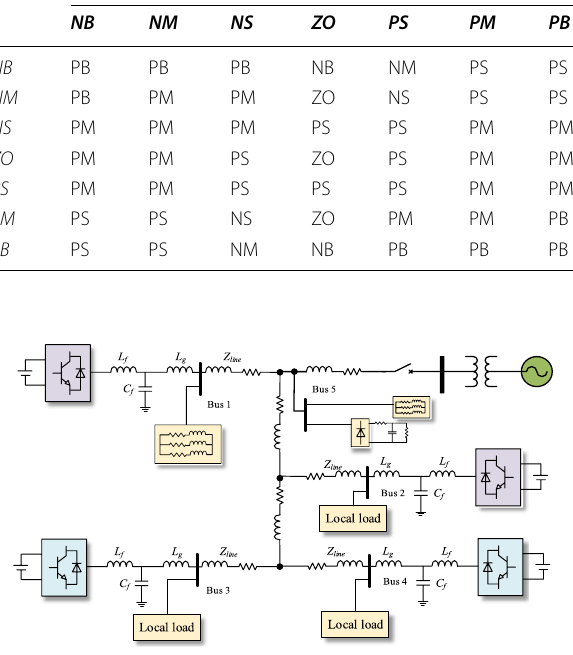
Fig. 18 Schematic diagram of an islanded microgrid in simulation studies